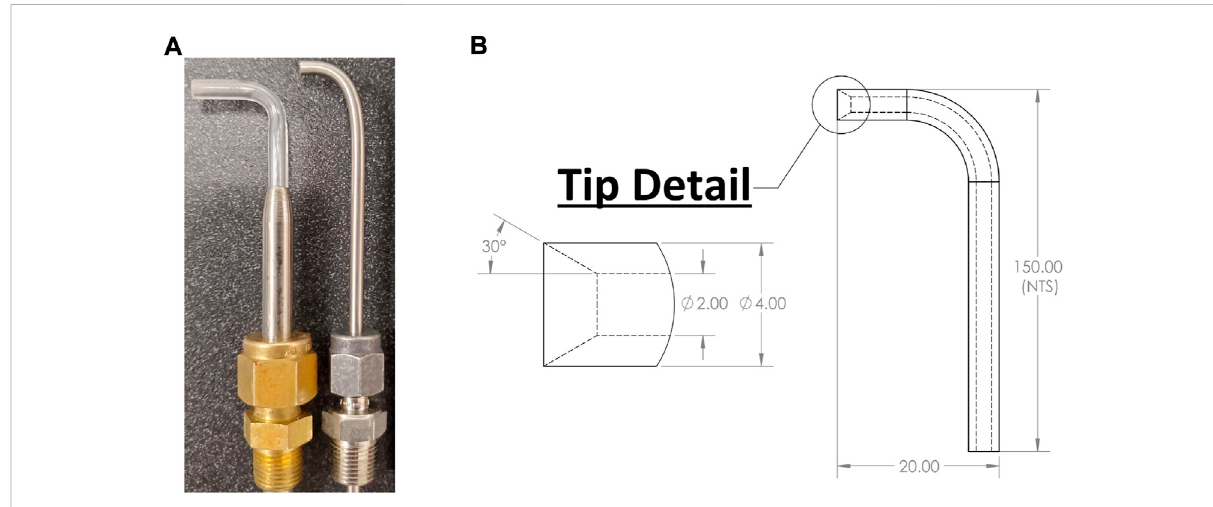
FIGURE 3 Sampling probe (left) placed next to early steel prototype (A) and probe dimensions in mm (B)